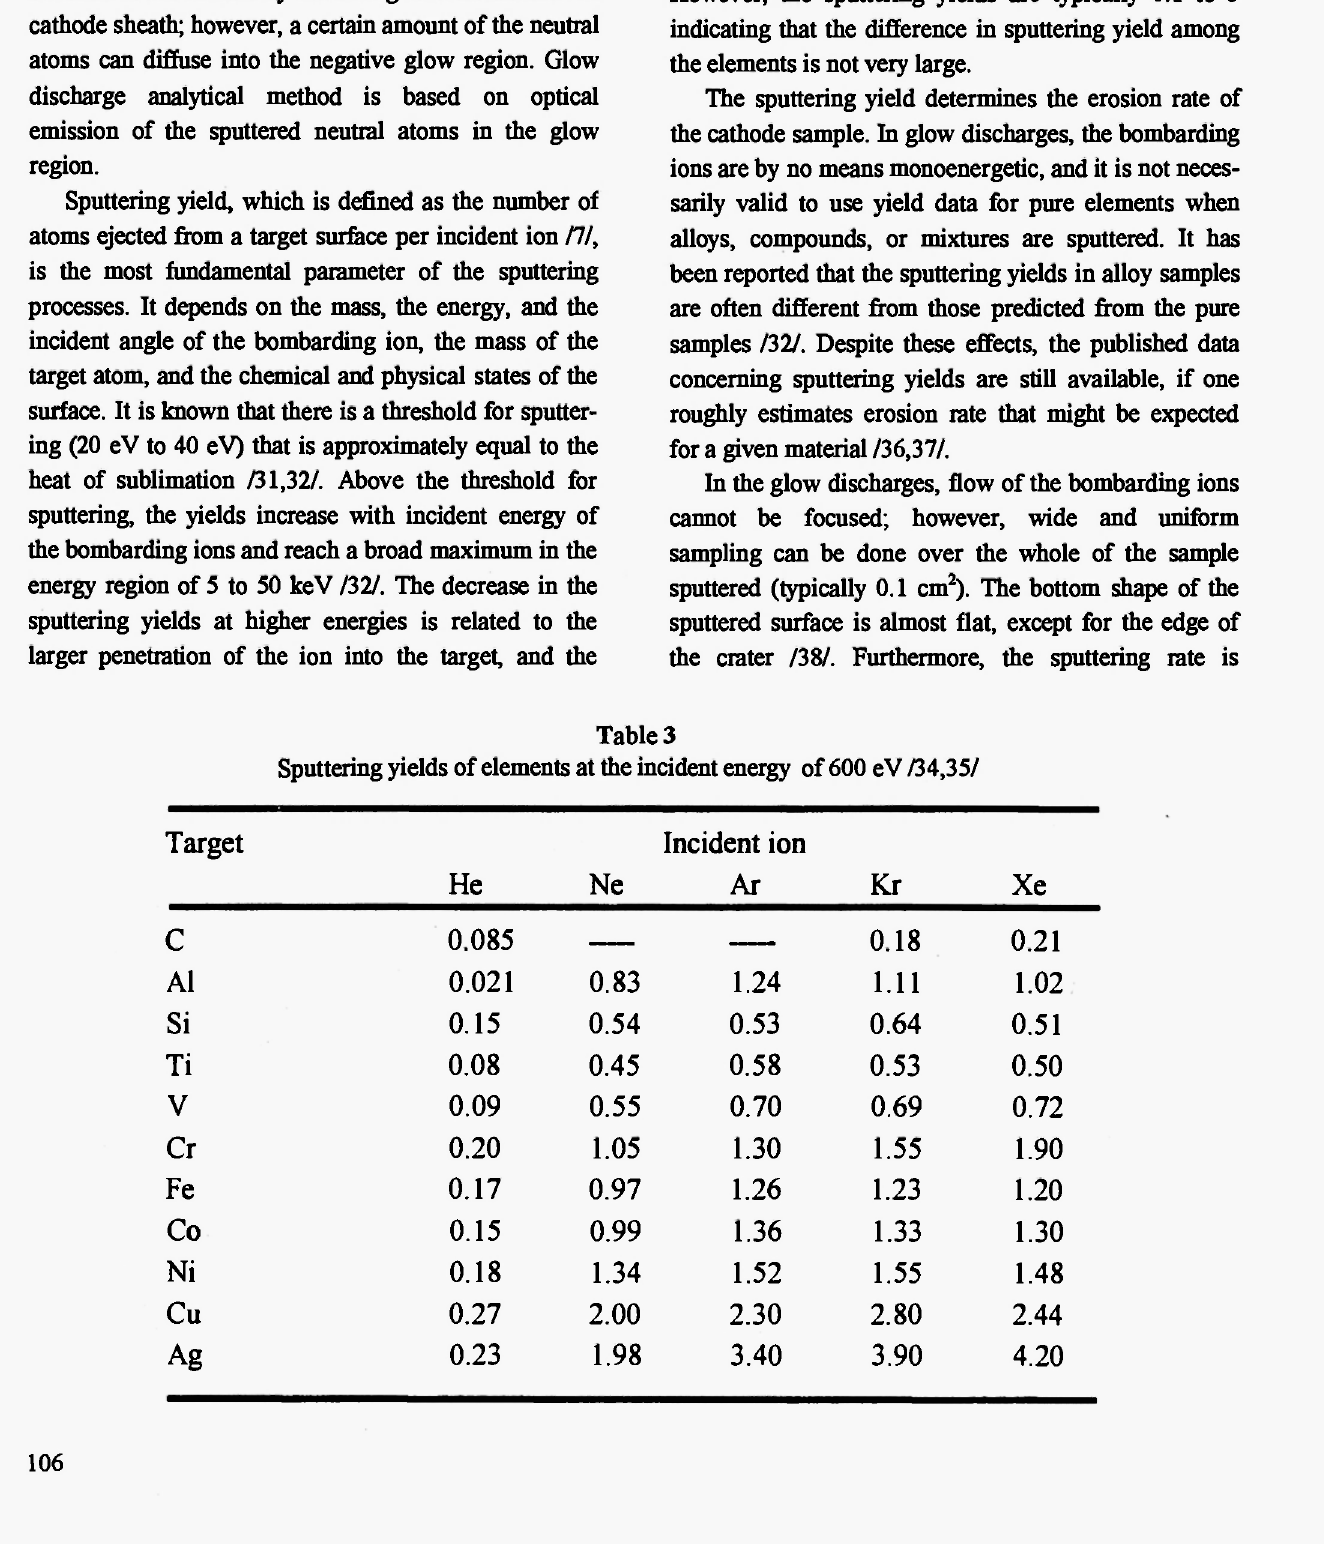
Sputtering yields of elements at the incident energy of 600 eV